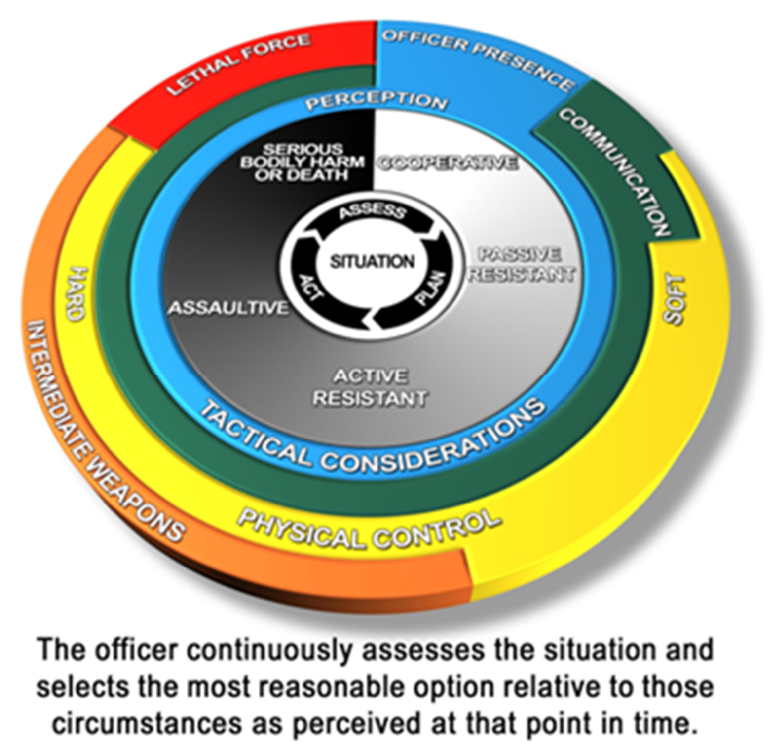
Figure 1. Ontario Use of Force Model. Image obtained from [6]. © Queen’s Printer for Ontario, 2004. Reproduced with permission.